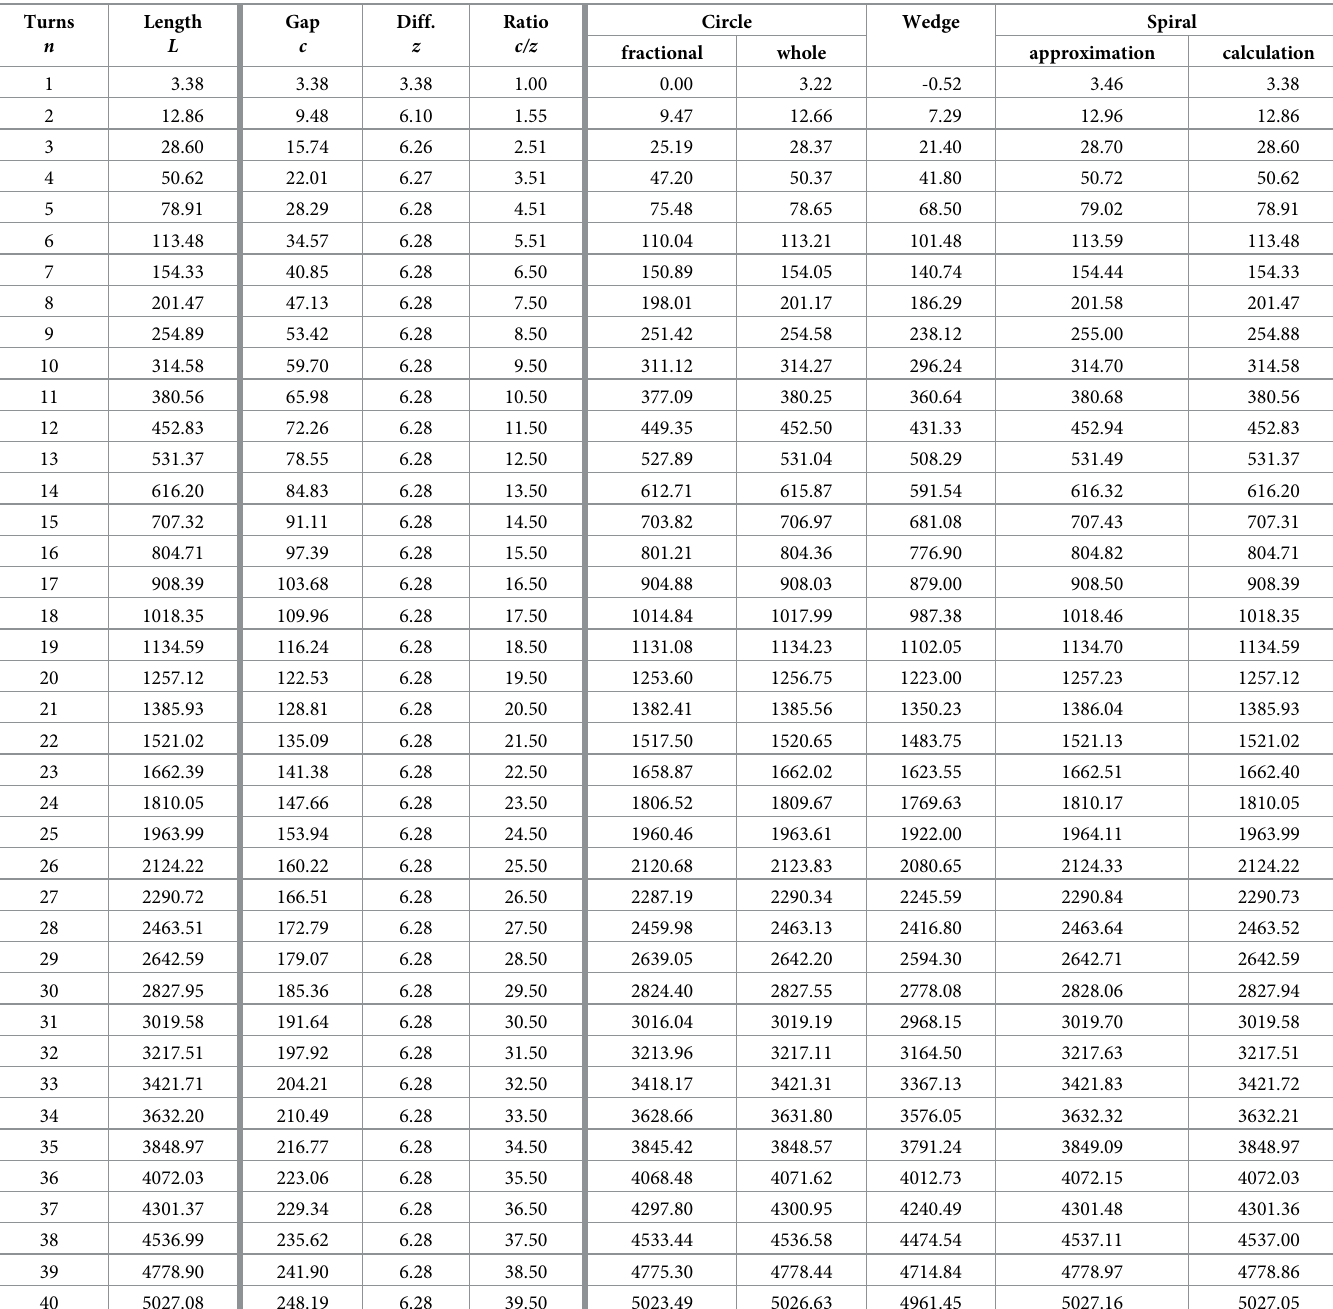
Table 2. Comparison of methods of estimating the length of the missing part of a spiral scroll. Turns n